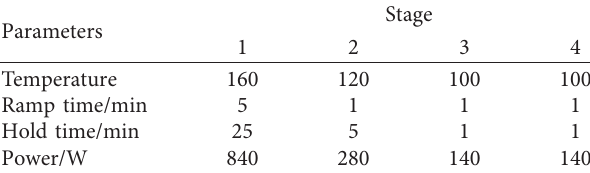
Table 1: Operating conditions of microwave